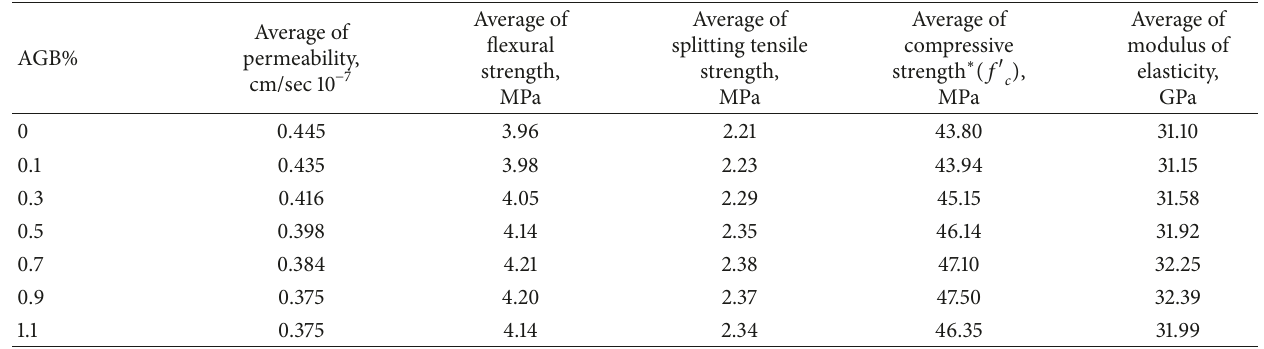
Table 3: Summary test